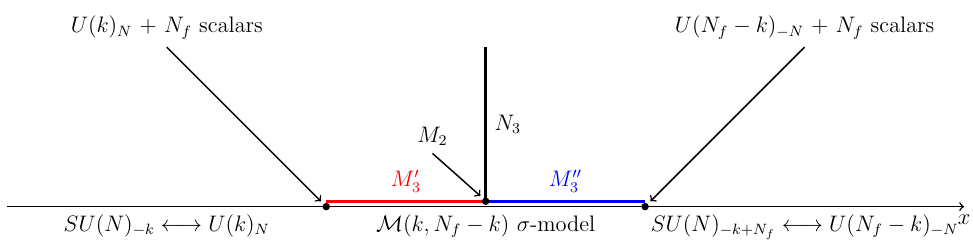
Figure 7: SU ( N ) − Chern-Simons theory coupled to N fermions with a spa- k + N f / 2 f tially varying mass m ∝ x . There are two interfaces separating the U ( k ) Chern- N ( k , N − k ) Grassmannian sigma model and the U ( N − k ) Simons theory, the − N f f M Chern-Simons theory. The interfaces can be described by the bosonic theories with a spatially varying mass squared. The sigma model has a Wess-Zumino term which consists of three components: N CS ( a ) on M (cid:48) (red), − N CS ( b ) on M (cid:48)(cid:48) (blue) and 3 3 N WZW ( g ) on N 3